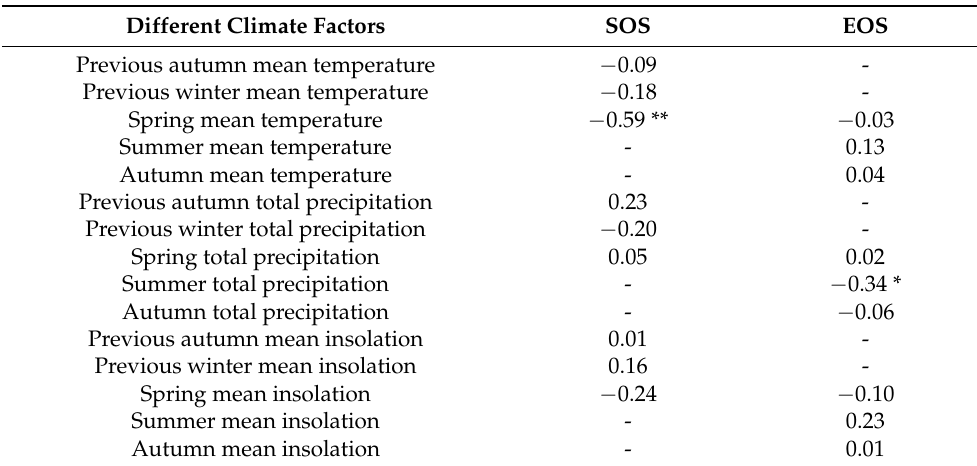
Table 2. Correlation coefficients between vegetation phenological parameters and climate variables in the entire study area during 1982–2014. Different Climate Factors SOS EOS Previous autumn mean temperature − 0.09 - Previous winter mean temperature − 0.18 - Spring mean temperature − 0.59 ** − 0.03 Summer mean temperature - 0.13 Autumn mean temperature - 0.04 Previous autumn total precipitation 0.23 - Previous winter total precipitation − 0.20 - Spring total precipitation 0.05 0.02 Summer total precipitation - − 0.34 * Autumn total precipitation - − 0.06 Previous autumn mean insolation 0.01 - Previous winter mean insolation 0.16 - Spring mean insolation − 0.24 − 0.10 Summer mean insolation - 0.23 Autumn mean insolation